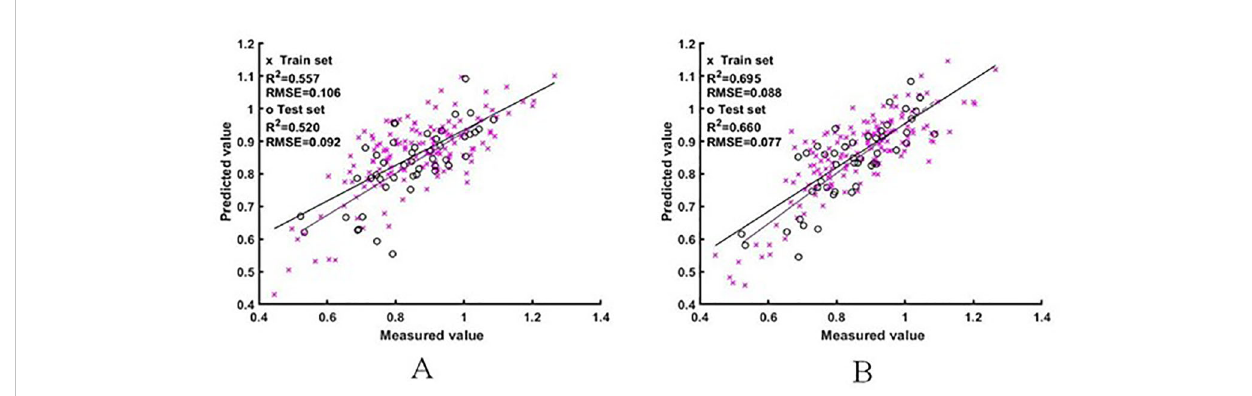
FIGURE 6 NNI estimation results based on logarithmic spectra [ (A) is the ELM model estimation result, (B) is the BES-ELM model estimation